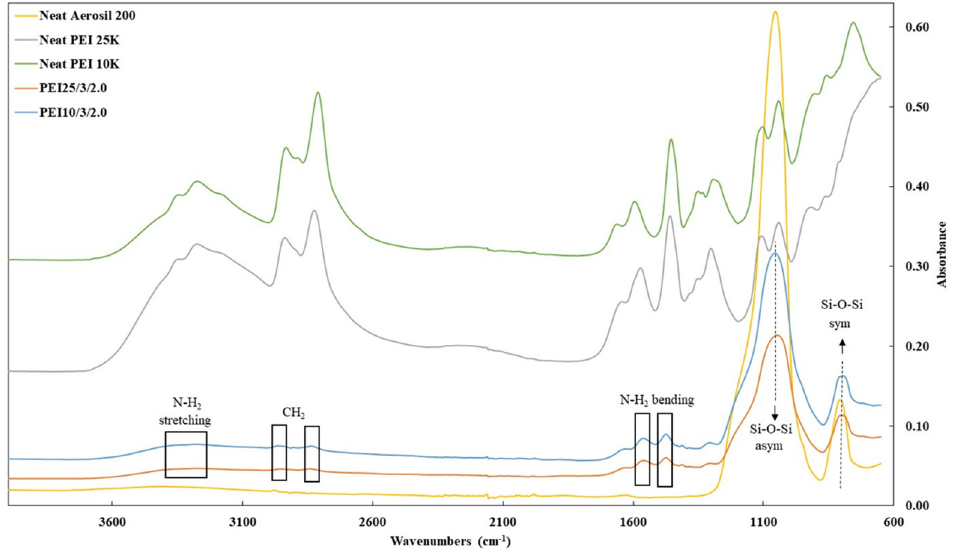
Figure 2. FTIR spectra of pristine silica Aerosil 200 (yellow line), PEI 25K (grey line) and PEI 10 K (green line), PEI25/3/2.0 (orange line) and PEI10/3/2.0 (blue line) before extrac-